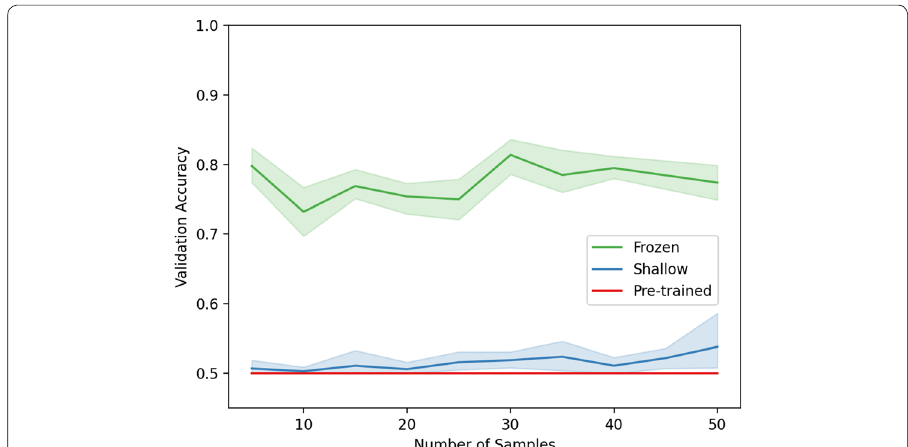
Fig. 3 Shown above is the accuracy achieved by each network at the corresponding sample sizes, from 5 to 50 samples in each UML category. For robustness, 5 trials were run for all training samples tested. The color bands indicate the distribution of results from the 5 trials